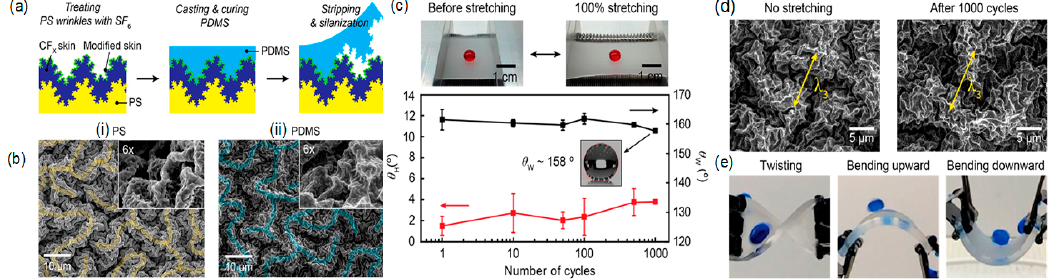
Figure 10. Monolithic formation of 3D hierarchical wrinkles in PDMS: ( a ) Process of casting PDMS against PS mold; ( b ) SEM images of hierarchical wrinkles on ( i ) PS mold and ( ii ) inverted structures on PDMS; ( c ) Superhydrophobicity satisfying both θ W > 160° and θ H < 3° was maintained on the 2D PDMS surface even after 1000 stretching cycles; ( d ) SEM images of surfaces before stretching and after 1000 cycles of stretching; ( e ) Optical images of water shedding on substrates under twisting, bending, and downward bending. Reproduced from [103] with permission; Copyright ACS 2014.